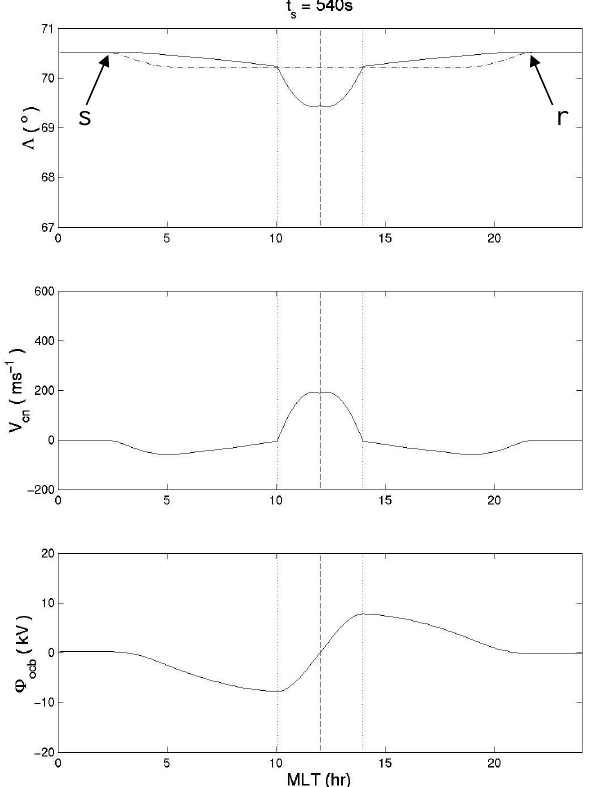
Fig. 1. A model output convection pattern for t s = 540s, just prior to the activation of the second pulse of magnetopause reconnection. At this point the convection from the first applied pulse of reconnection has started to decay. The top panel shows the variation with simu- lation time, t s , of the input reconnection voltage (in blue), 8 XL di- vided by five to fit the same scale as the resulting transpolar voltage (in red), 8 PC . The vertical green line marks the simulation time of the output frame. The lower panel shows the convection pattern (using equipotentials 3kV apart) plotted in an MLT–magnetic lati- tude coordinate system. The outer circle represents the equatorward boundary of the modelled region (i.e. the region 2 FAC ring) and the inner circle represents the OCB. Non-reconnecting segments of the OCB are shown in black (in this case no reconnection is ongoing and so the entire OCB is black). The green line delineates the re- gion of newly-opened flux produced by the first reconnection pulse. The open flux at this t s is F PC = 8 . 17 × 10 8 Wb, showing that the first pulse added 1 . 7 × 10 7 Wb of open flux.